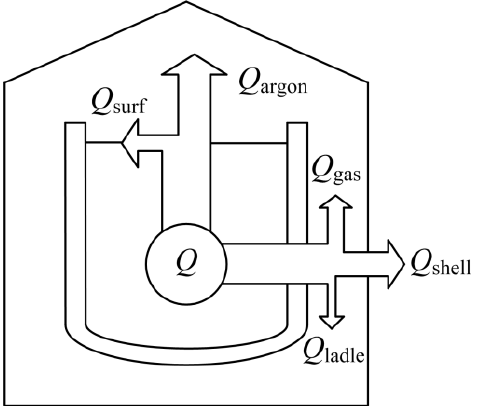
Figure 2. The energy conservation of VTD ( Q surf , heat loss from the top surface; Q argon , heat loss due to argon stirring; Q gas , heat loss of the gas used during vacuumizing and vacuum breaking; Q ladle , heat content absorbed by ladle lining; Q shell , convection loss to atmosphere from ladle